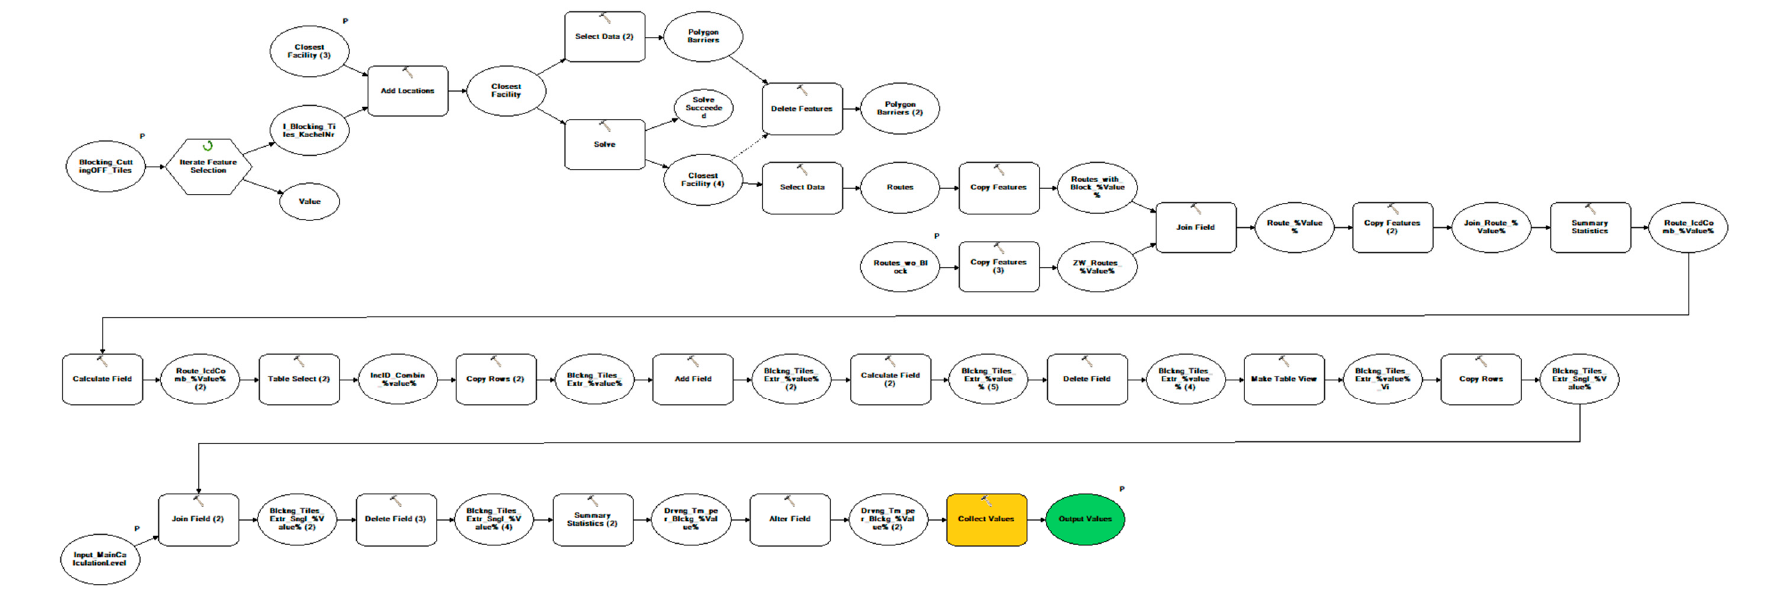
/ cut o ff tiles level in ArcMap